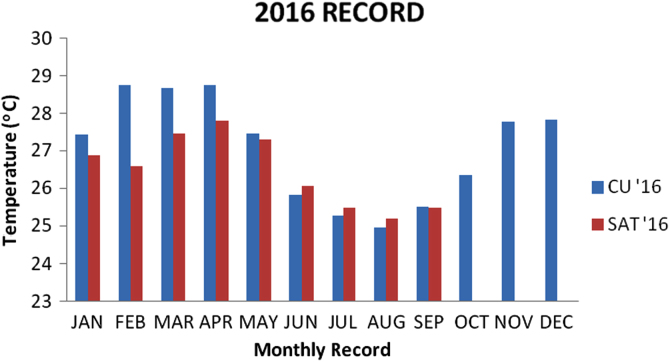
Chart for 2016 Data.